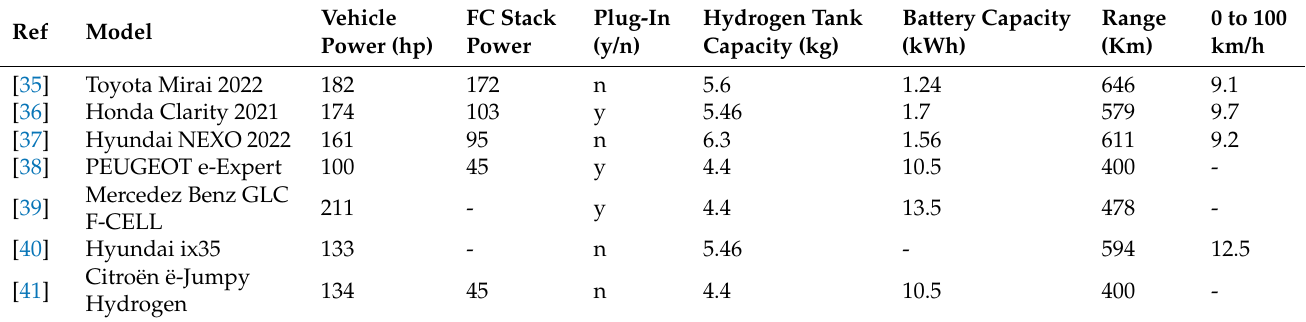
Table 2. FCHEV model